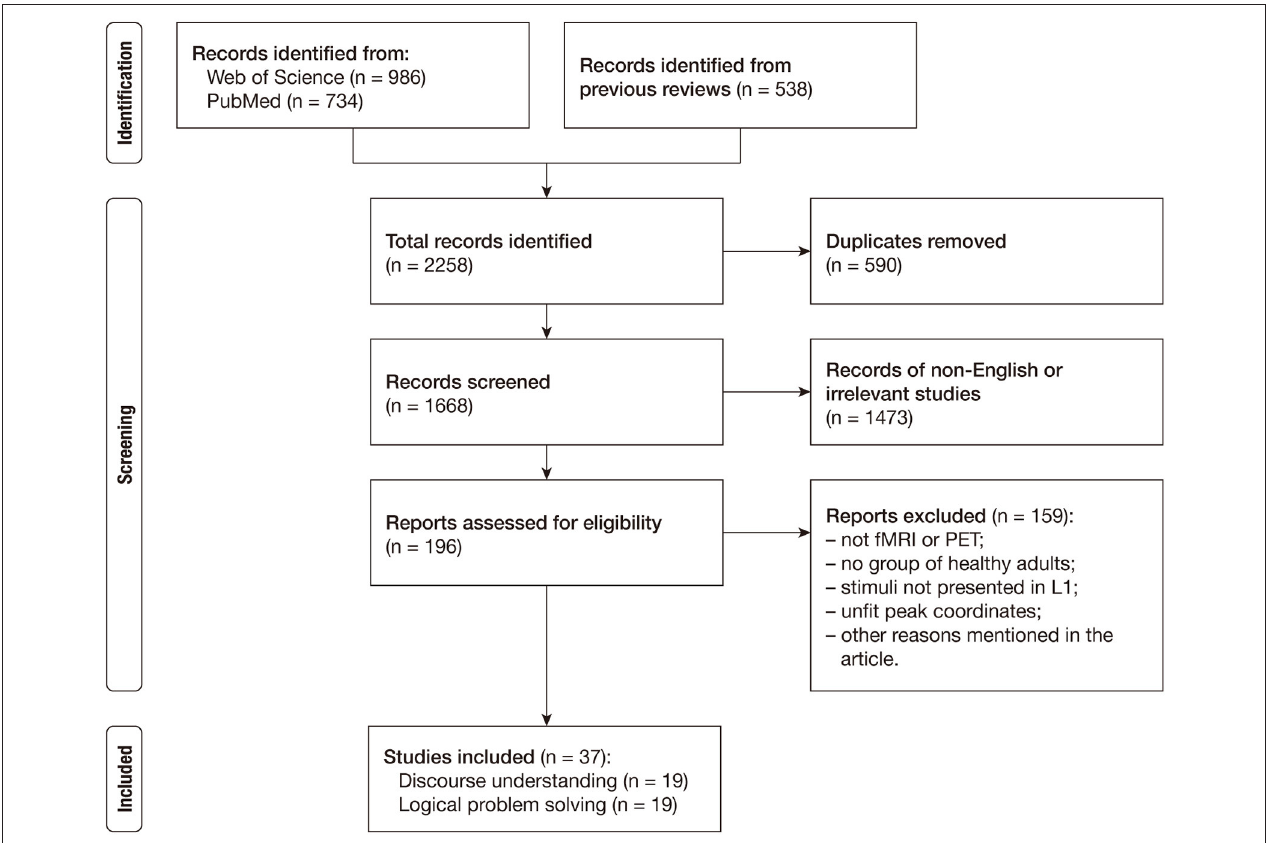
FIGURE 1 | Flowchart of study